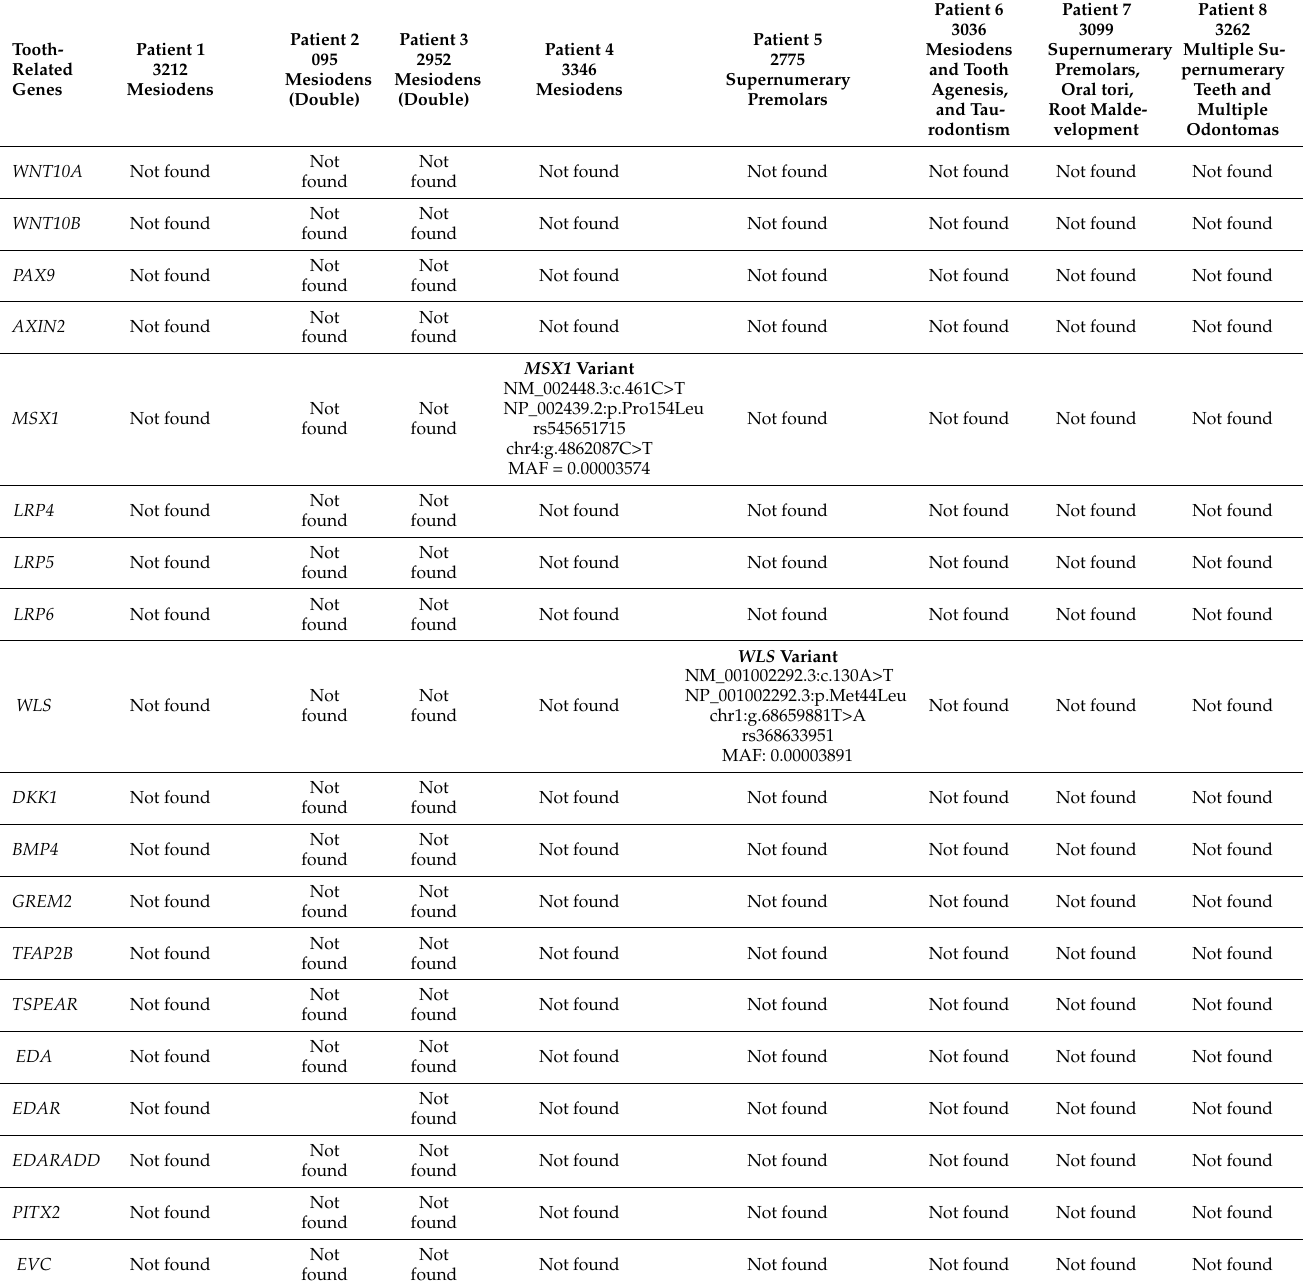
Table 3. Genetic variants with allele frequencies less than 0.0001 (MAF < 0.0001) according to gnomAD in tooth-related genes in patients with FREM2 variants with mesiodens or isolated supernumerary